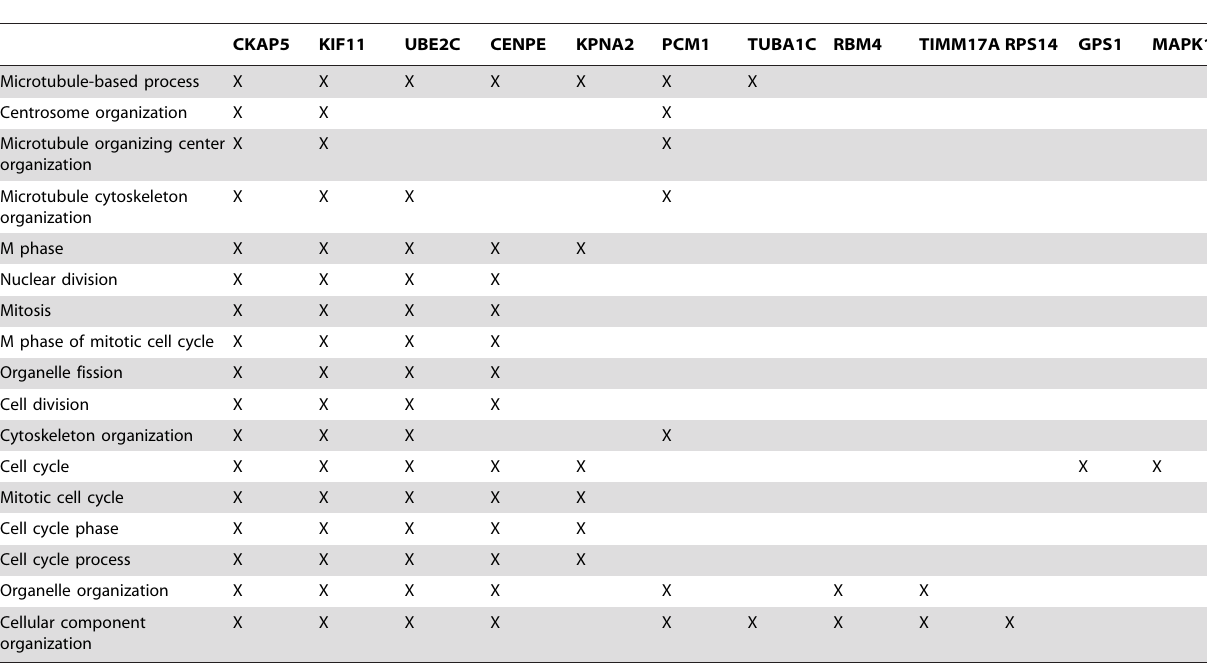
Table 2. Functional annotation of potential miR-155 target proteins in HEK293T